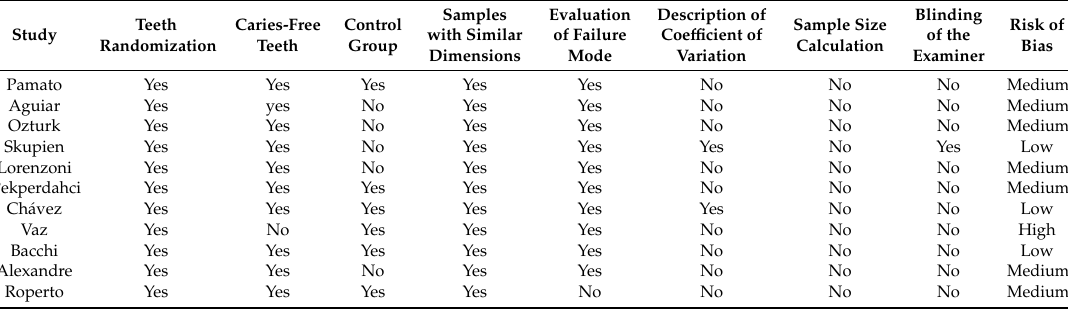
Table 1. Risk bias